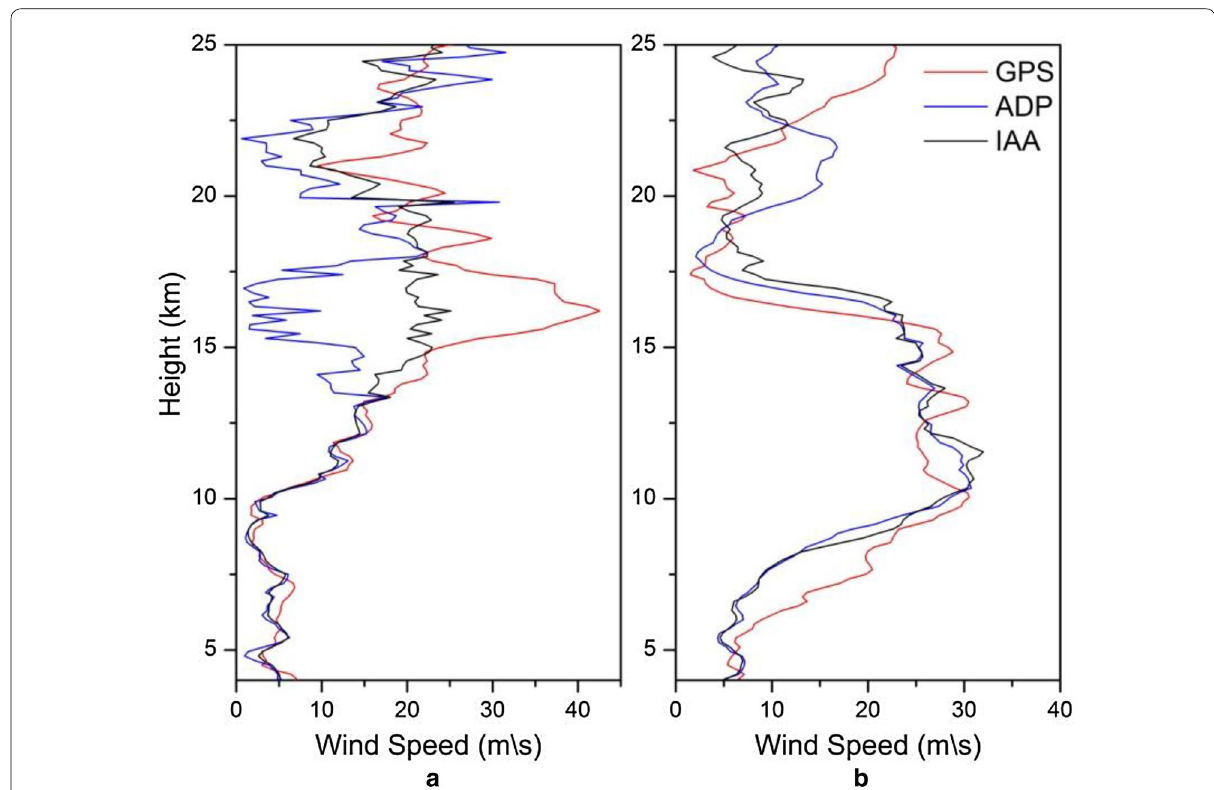
Fig. 8 Wind speed using ADP, IAA and GPS radiosonde for radar data collected on a July 2, 2014 b February 9, 2015—Comparison